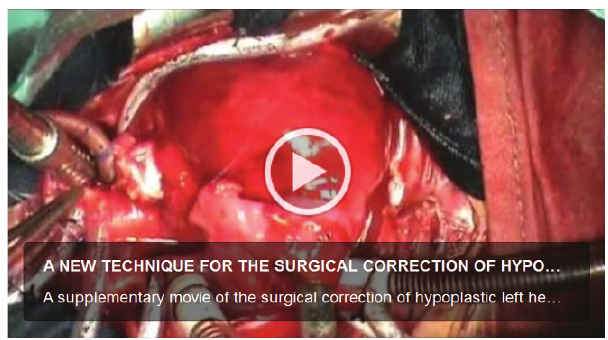
Figure 5 - A supplementary movie 1 of the surgical correction of hypoplastic left heart syndrome (stage 1) performed with the new proposed